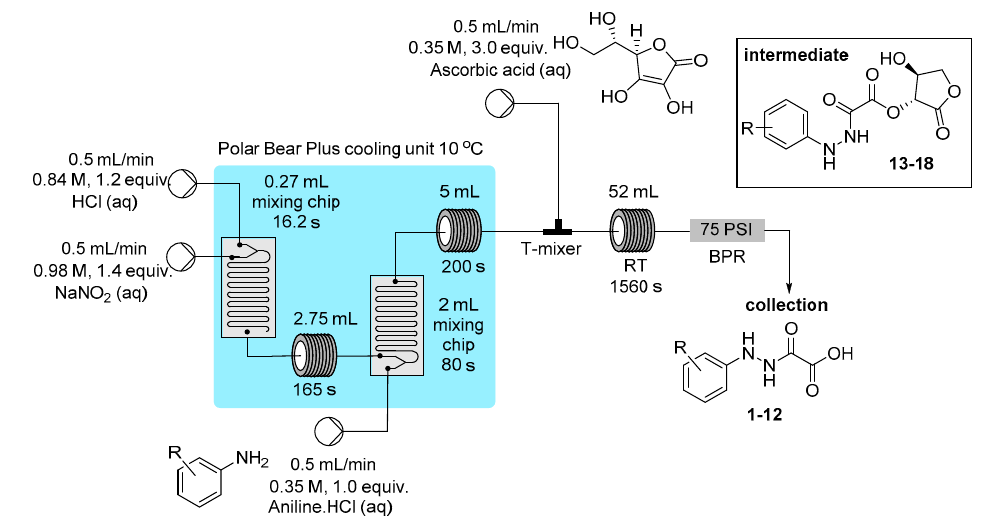
Figure 3. Flow reactor setup for diazotization at high flow rates.